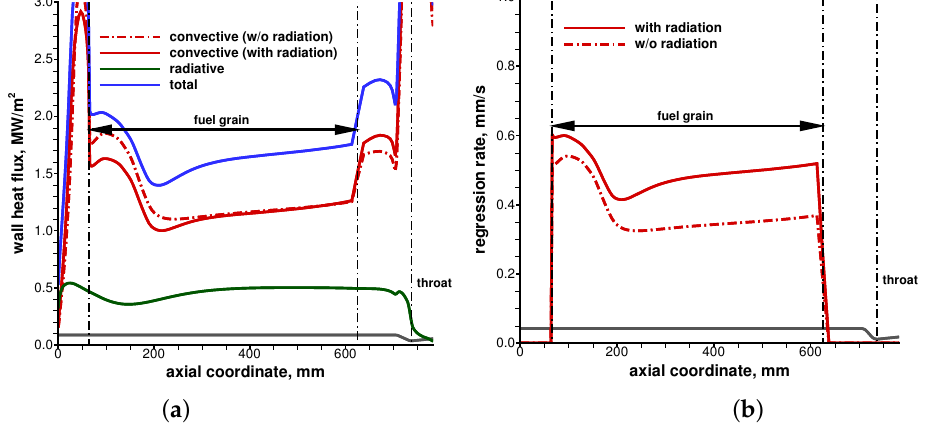
Figure 11. Axial distributions (with and without radiative energy exchange) of surface parameters for Firing Test #18: ( a ) convective and radiative heat flux; ( b ) regression